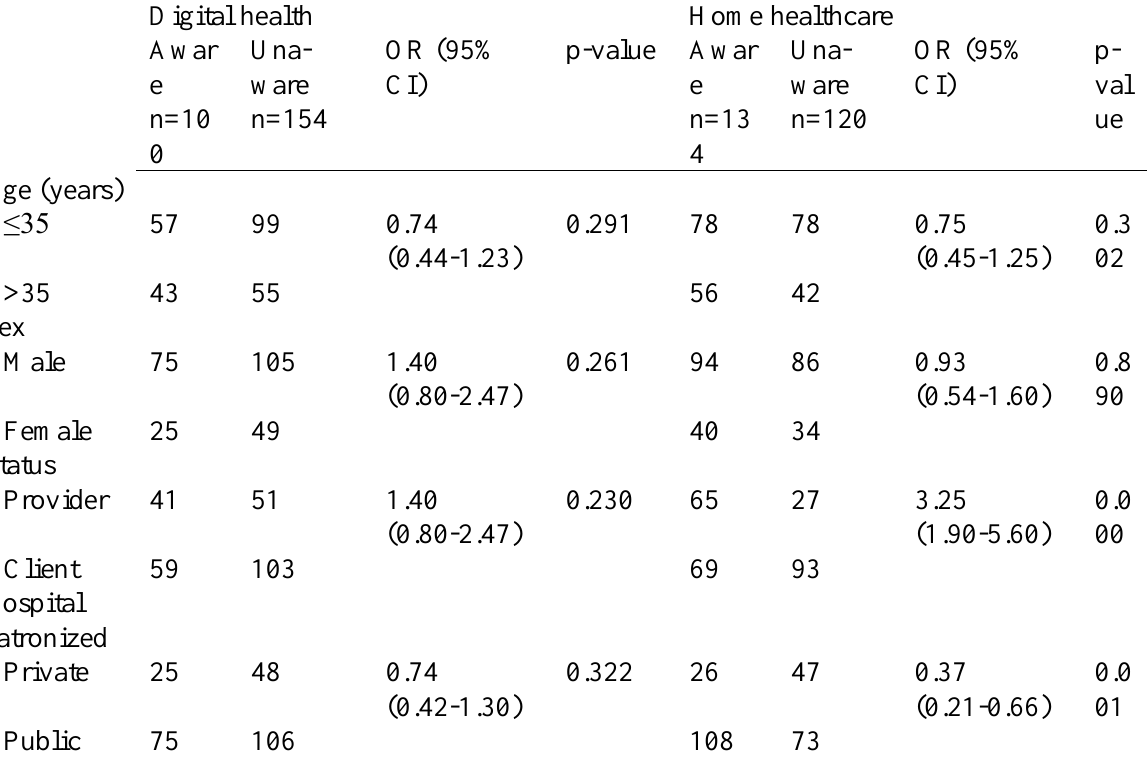
Table 2: Awareness of digital health and home